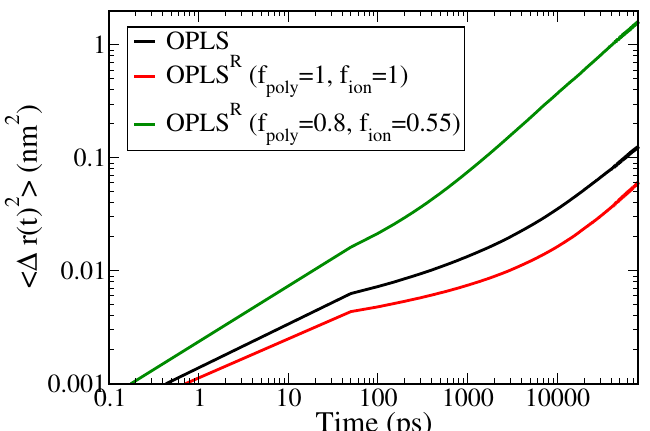
Figure 7. The mean square displacement profiles of Li + in PEO/LiTFSI SPE system at 333 K for three tested force